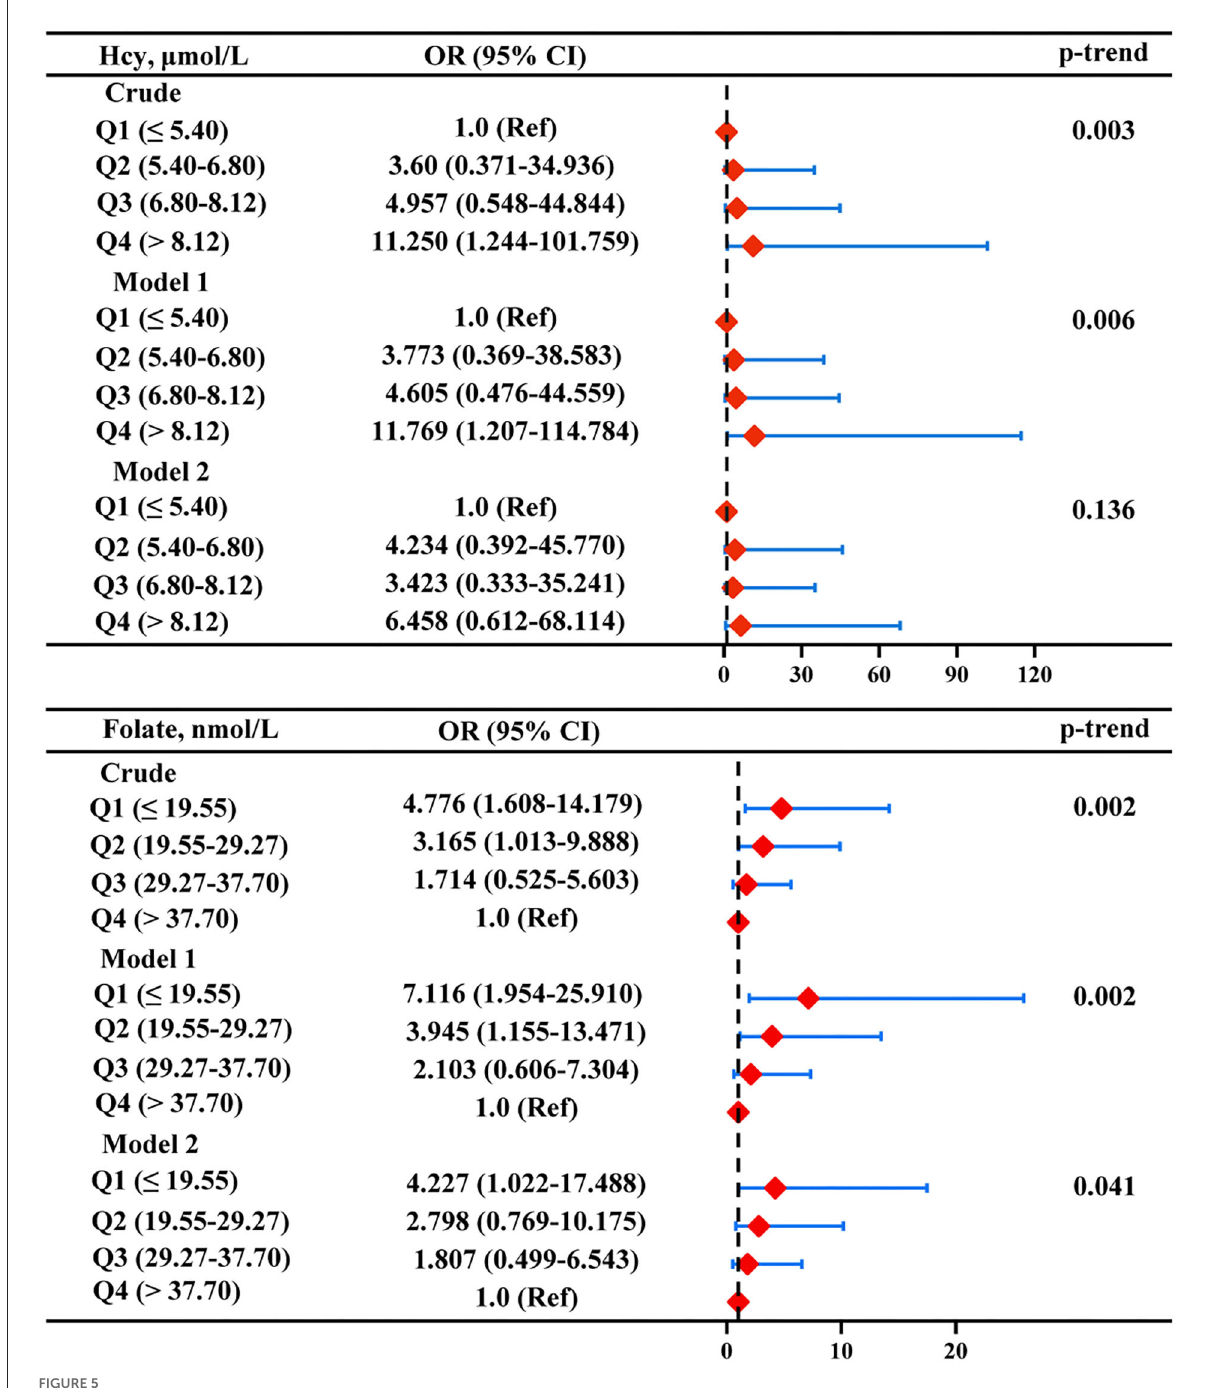
FIGURE5 Multiple logistic regression analysis for the associations between serum Hcy and folate and severity of ASD. Model 1 was adjusted for age, sex, BMI, picky eating, and use of vitamins. Model 2 was adjusted for model 1 and the other two metabolites. Red diamonds represent the adjusted OR, and horizon lines represent 95% CI. P-values for the trend test (p-trend) were obtained from the multiple logistic regression models by using the median of each parameter quartile (ln-transformed serum homocysteine and folate concentrations) as a continuous variable. Hcy,